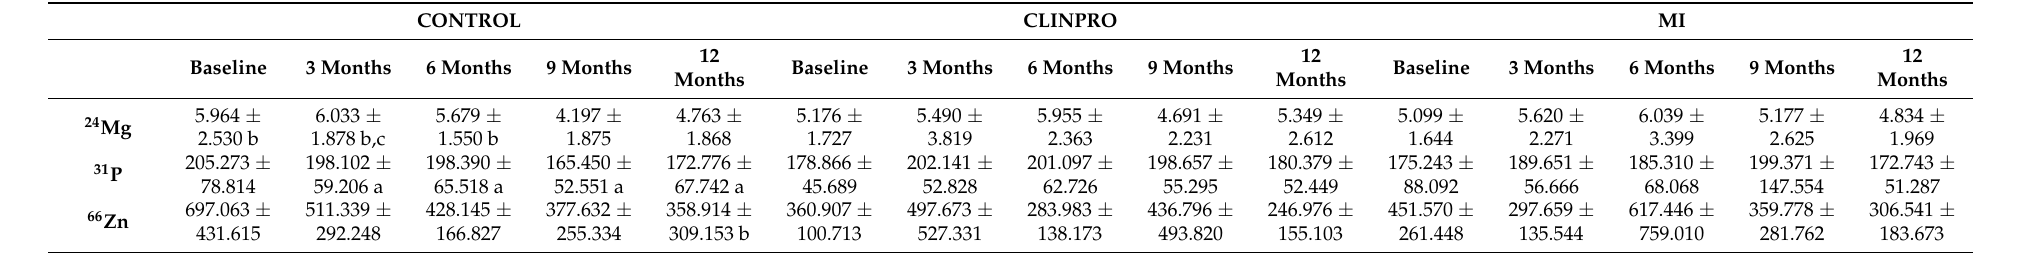
Table 6. Chemical elements with significant